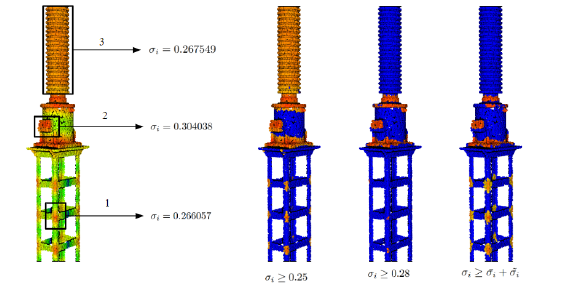
Figure 7. Structural chunk of an industrial object coloured by saliency and remaining points for different extraction methods.